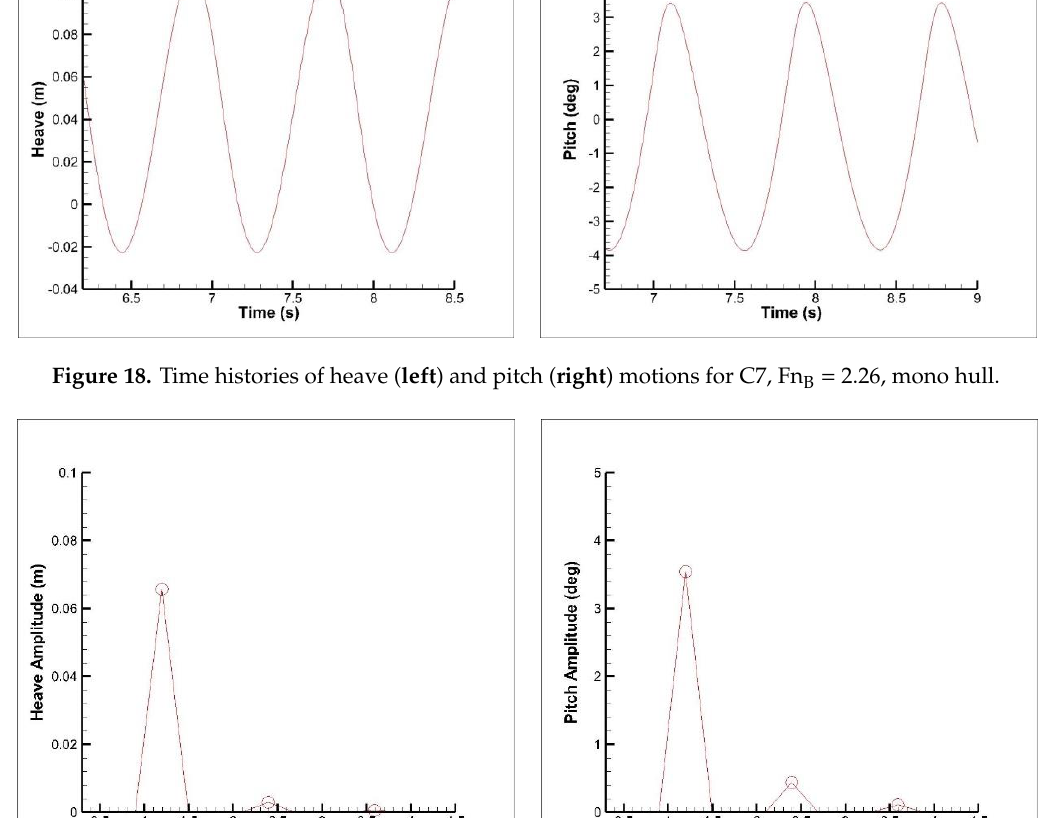
Figure 19. Frequency domain response of heave ( left ) and pitch ( right ) motions for C8, Fn B = 2.82, warped